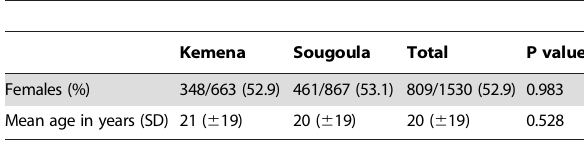
Table 1. Sex and age of individuals in the villages of Kemena and Sougoula at the time of enrollment.